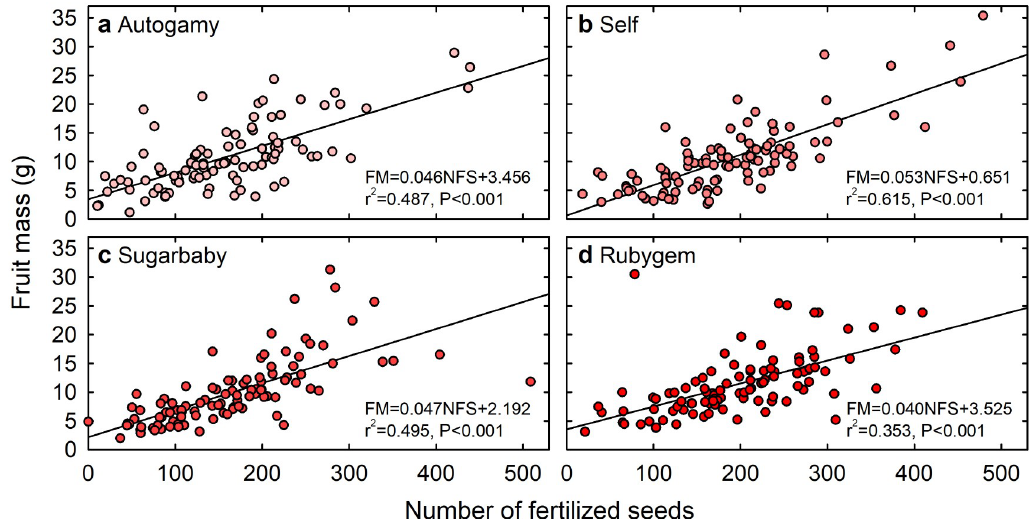
Fig 7. Relationship between the number of fertilized seeds and fresh mass of Redlands Joy strawberry fruit arising from unassisted self-pollination (Autogamy) or hand-pollination with self-pollen (Self) or cross-pollen from another cultivar (Sugarbaby or Rubygem) (linear regression, P < 0.001; n = 100 fruit).